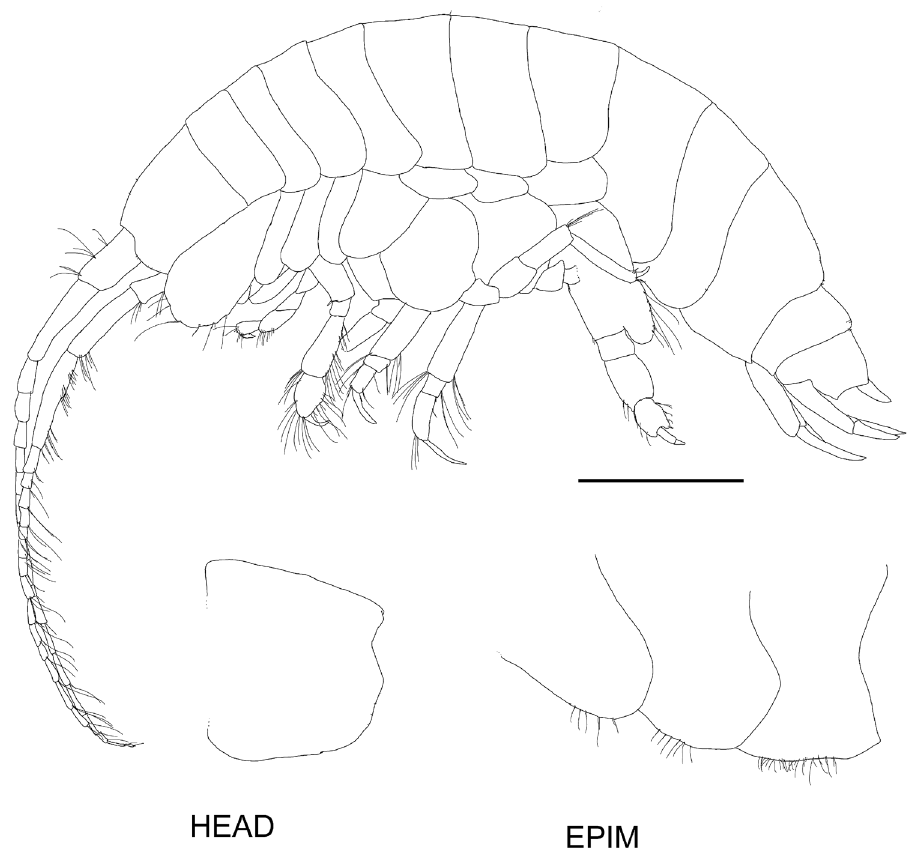
Figure 9. Haploops kaimmalkai sp. n. holotype, female, 6 mm, ZMH K-47057, Iceland Basin, 1384.8– 1389 m. Scales represent 0.2